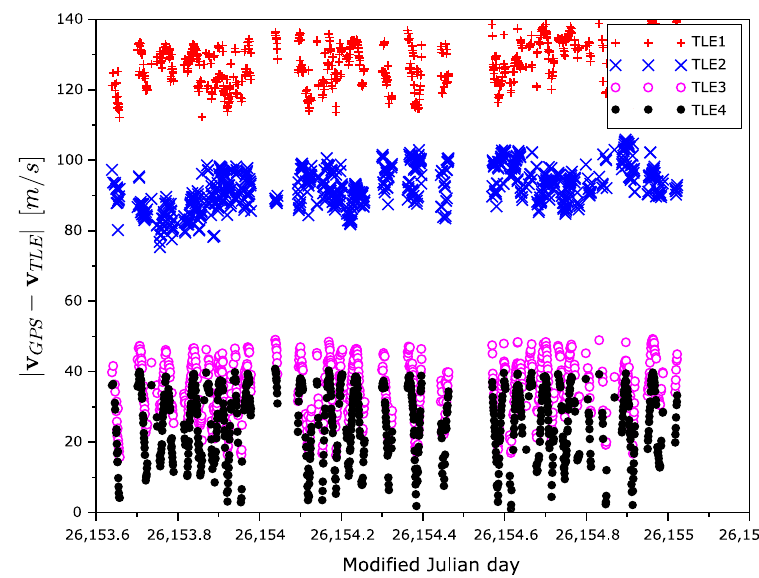
Figure 13. Velocity error magnitude as a function of time.